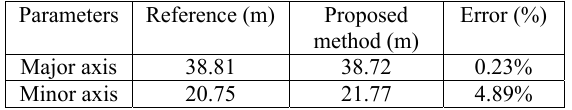
Table 4: Validations of cylinder shape parameters in the case of close-range photograph.